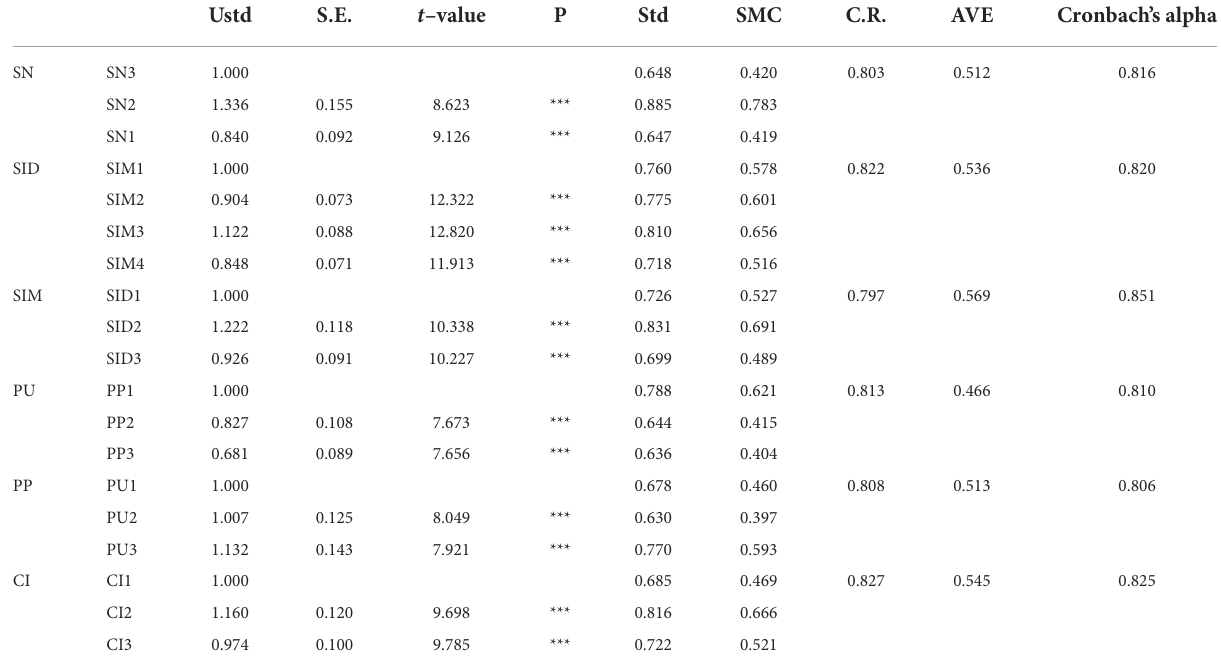
TABLE 4 CFA analysis results.